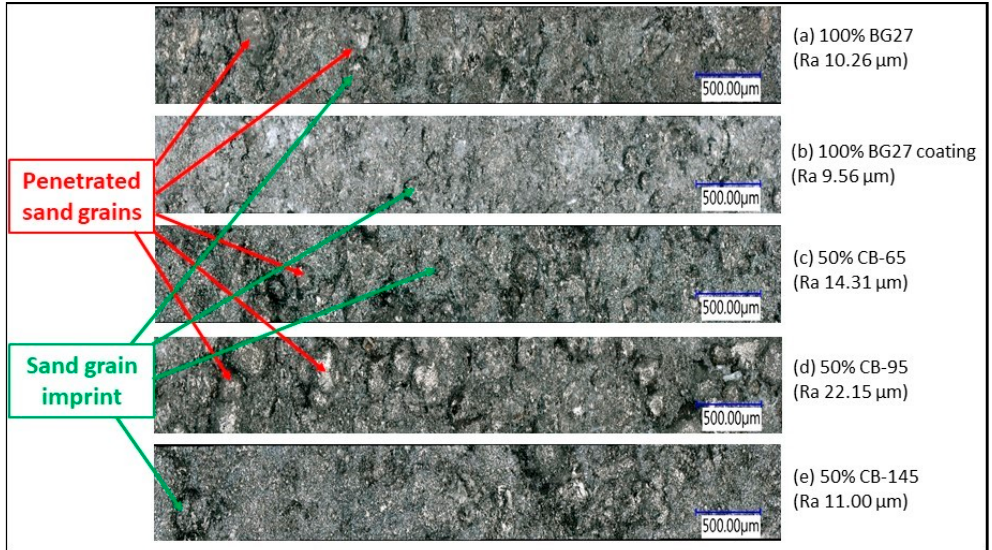
Figure 6. Cast surface roughness of concrete samples on BG27 reference castings and castings with 50% CB addition. The roughness Ra is given for the specific photograph of the specimen from which it was determined.